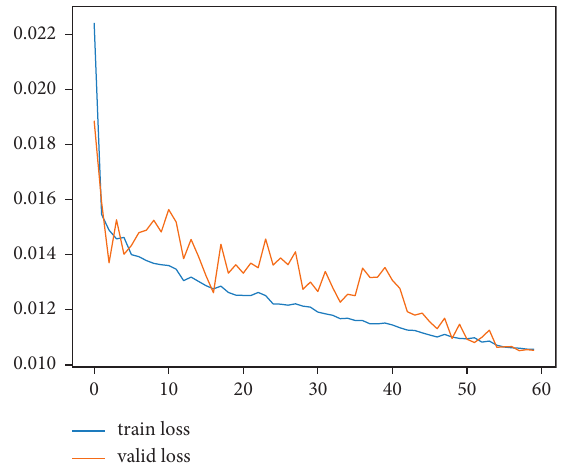
Figure 6: A typical FEB-LCR-ACM training loss curve for LHV-SIX.